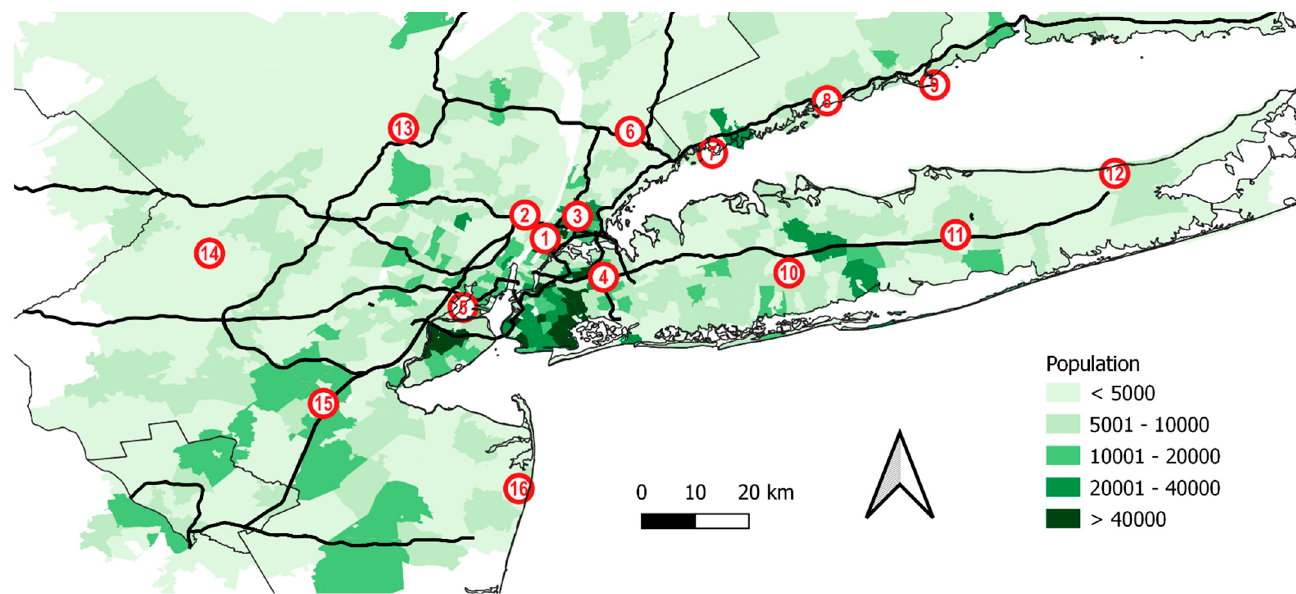
Figure 1. The locations of air quality sites, 2019 population (by US Census track [20]) and primary road network in the study area. The numbers in the circle refer to sites ID# in Table 1.